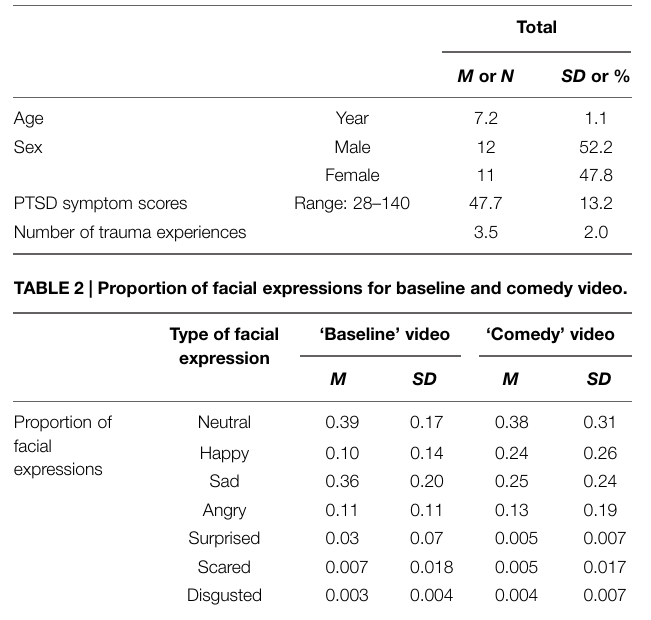
TABLE 1 | Characteristics of sample ( N = 23).